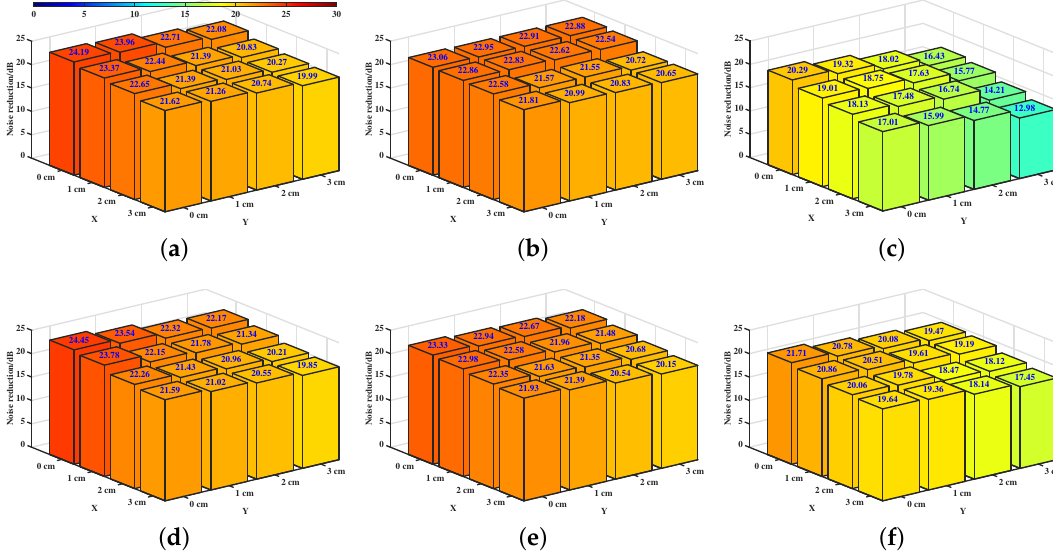
Figure 6. Three-dimensional histograms of the reduction results at the left ear when the secondary loudspeakers were moved at different distances with various VS methods and headrest structures. ( a ) AFM, fixed structure/proposed adjustable structure. ( b ) RMM, fixed structure/proposed adjustable structure. ( c ) Virtual microphone method (VMM), fixed structure/proposed adjustable structure. ( d ) AFM, movable microphone structure. ( e ) RMM, movable microphone structure. ( f ) VMM, movable microphone